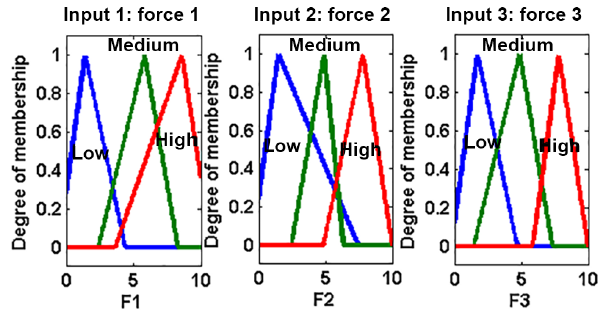
Figure 16. Optimized Fuzzy sets of inputs.